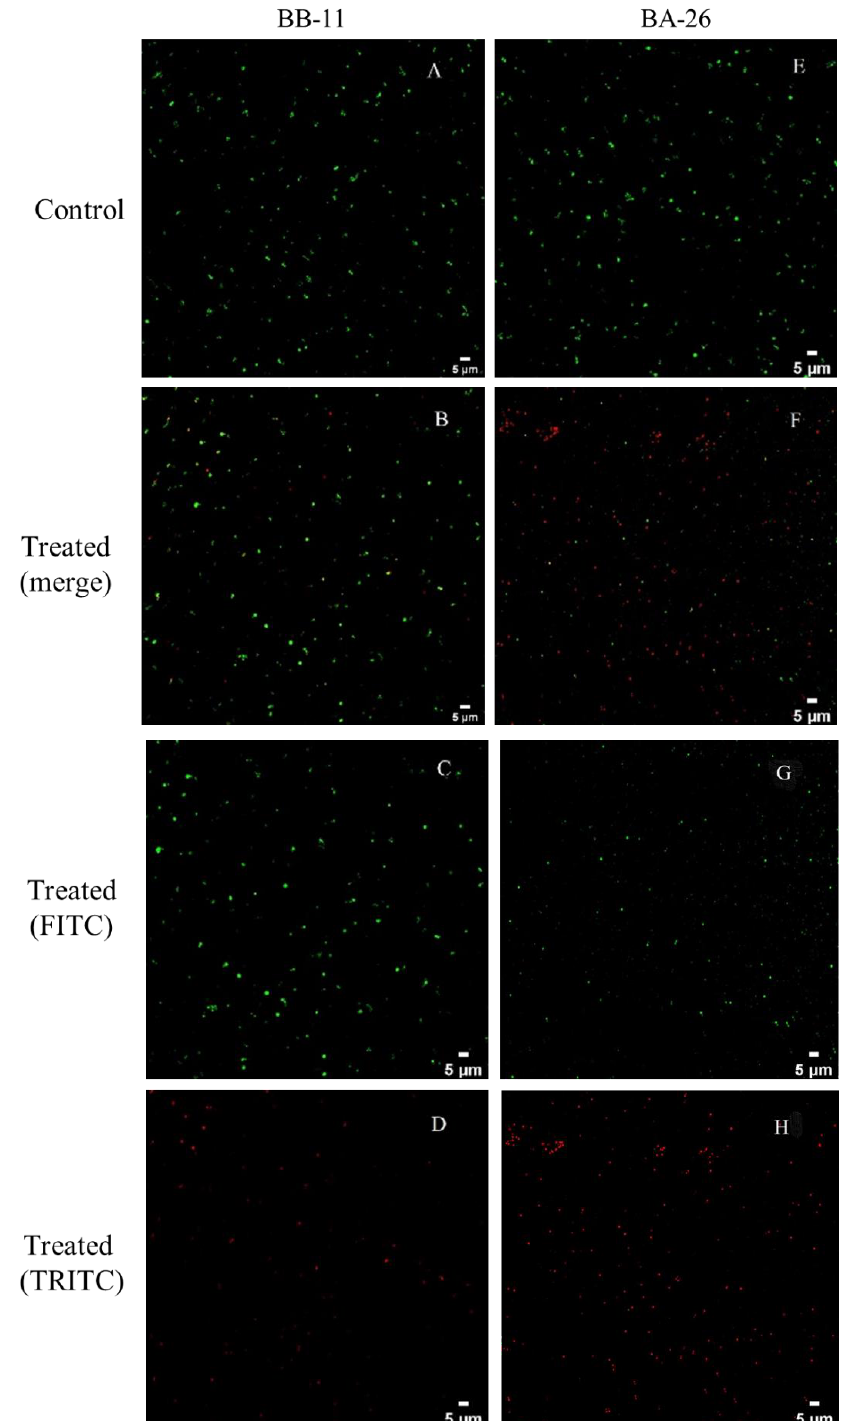
Figure 3. Confocal laser scanning microscopy images of S. aureus in the late exponential stage and exposed to low temperature (4 °C). ( A , E ): BB-11 and BA-26 without low temperature treatment; ( B , F ): merge images with full fluorescence channel of BB-11 and BA-26 after low temperature treat- ment; ( C , G ): green fluorescence channel (FITC) images of BB-11 and BA-26 after low temperature treatment; ( D , H ): red fluorescence channel (TRITC) images of BB-11 and BA-26 after low temperature treatment The green fluorescence (stained with calcein-AM) indicates that the cell membranes remain intact and bacteria are considered live, and the red fluorescence (stained with propidium iodide) indicates the disruption of membranes and bacteria are considered dead. Scale bar = 5 μm for each CLSM image.